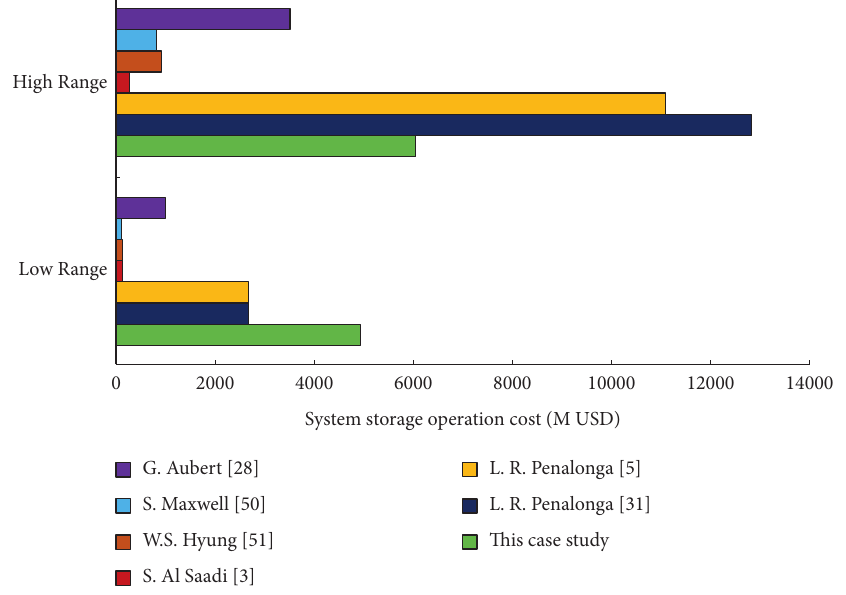
Figure 22: Comparison of storage system total cost with those of other studies. Table 16: Summarized comparison with other case